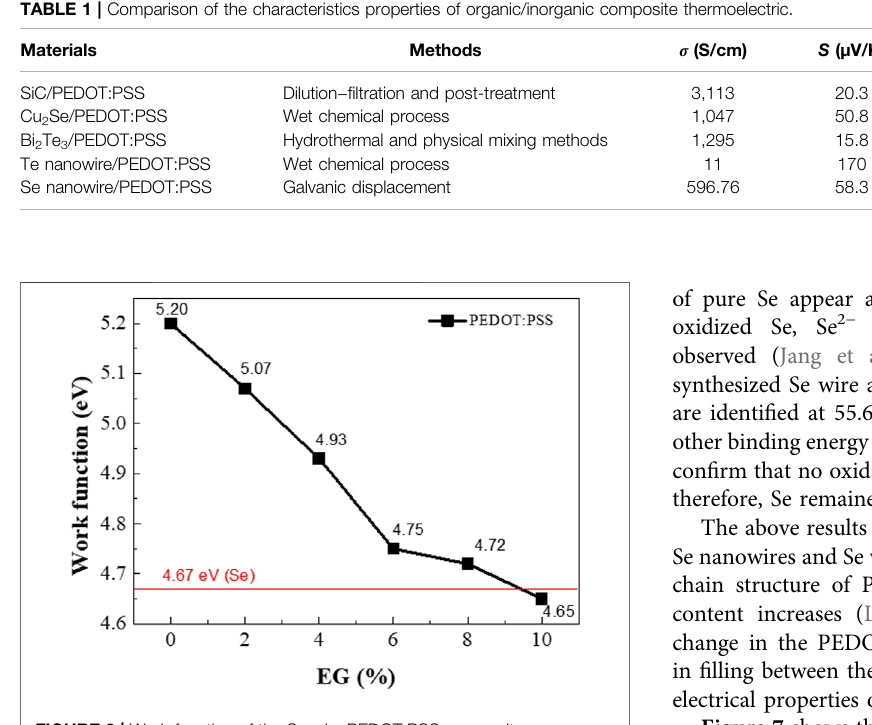
FIGURE 8 | Work function of the Se wire:PEDOT:PSS composite as a function of the EG doping concentration.